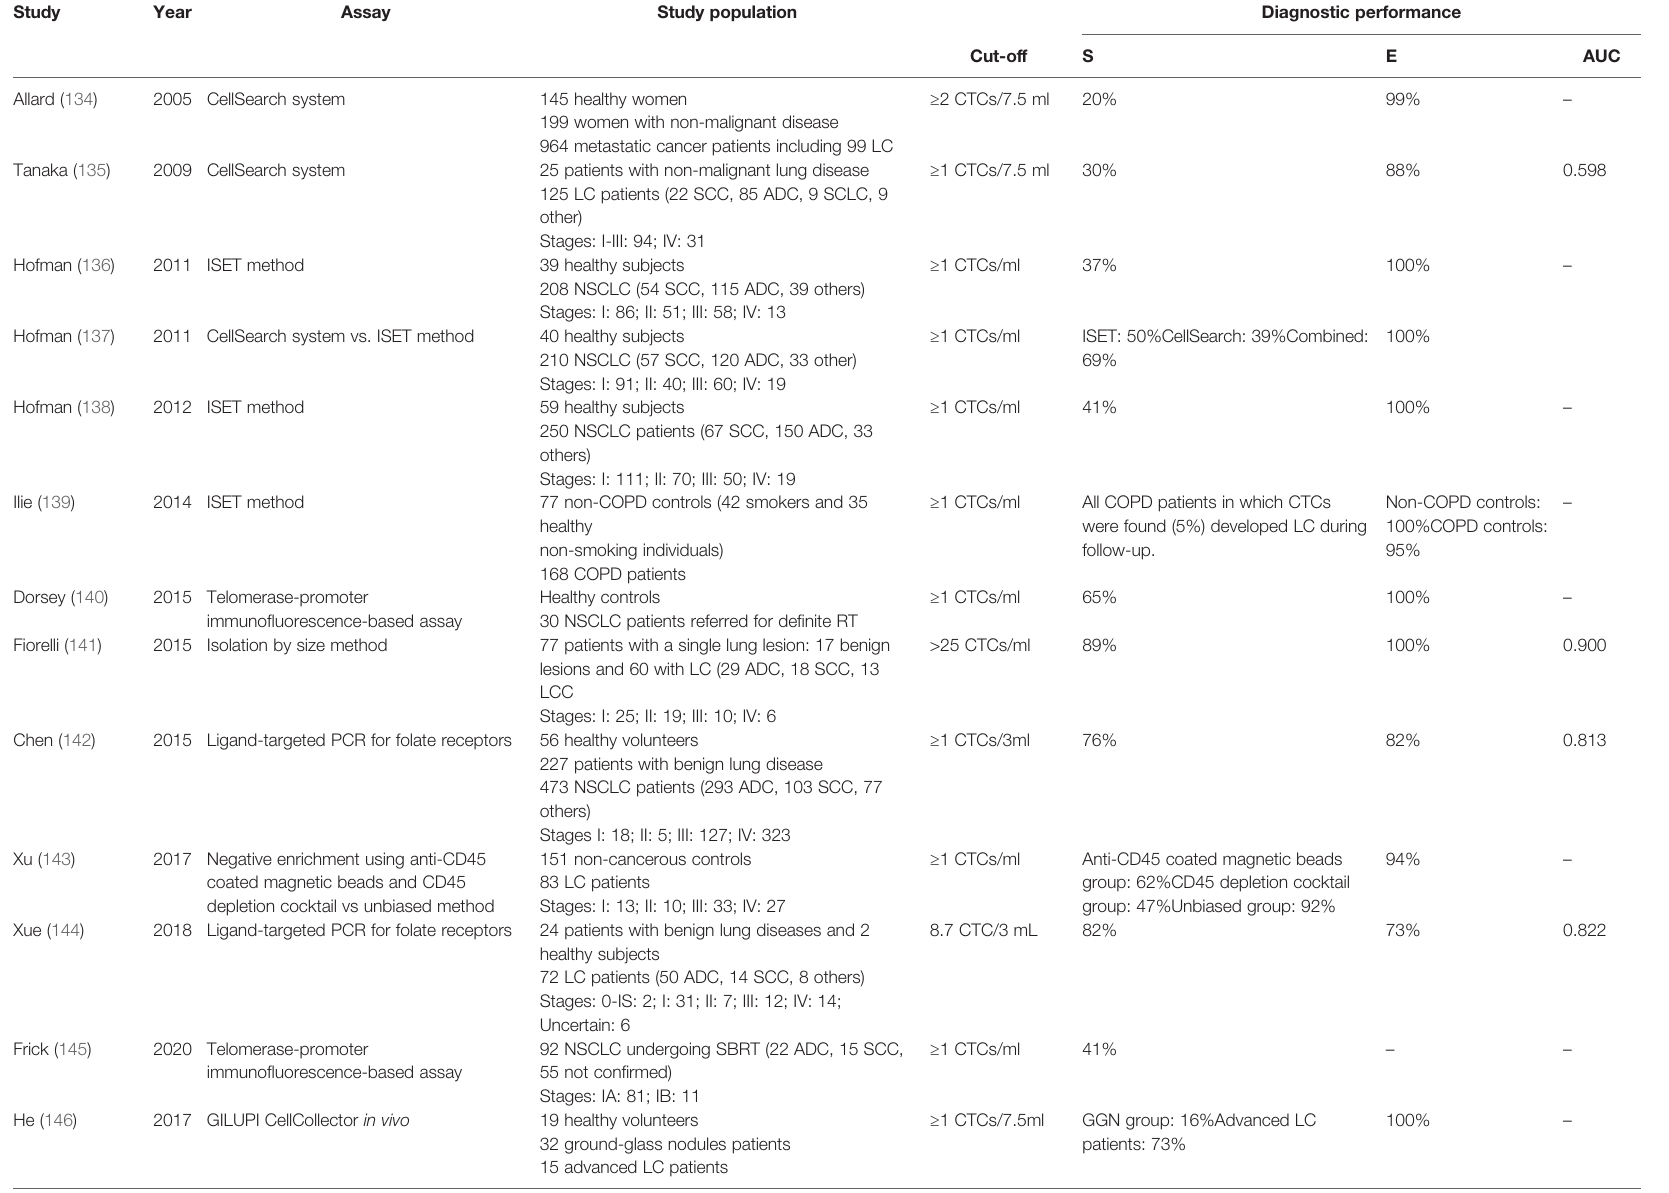
TABLE 5 | Circulating tumor cells (CTC) as biomarker for lung cancer